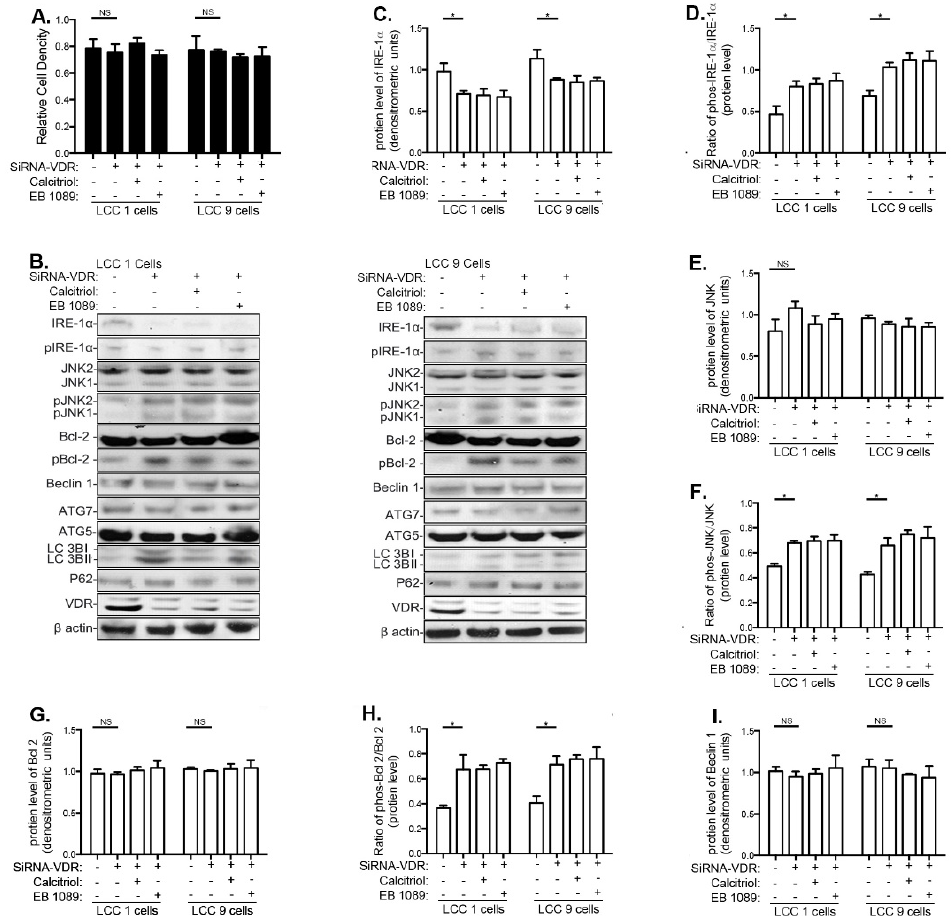
Figure 5. Silencing VDR prevents the activation of the IRE1 α -JNK signaling pathway in calcitriol- and EB1089-treated breast cancer cells. ( A ) siRNA- and siRNA-VDR-transfected LCC1 and LCC9 cells were treated with vehicle (ethanol), calcitriol (100 nM) or EB1089 (100 nM) for 3 days post-transfection. Relative cell density was determined by crystal violet assay. ( B ) Representative blot from Western blot analysis of siRNA-VDR-transfected LCC1 and LCC9 cells treated with either calcitriol or EB1089. Quantification of protein expression level of ( C ) total IRE1 α , ( D ) the ratio of pIRE-1 α over total IRE-1 α , ( E ) total JNK, ( F ) the ratio of pJNK over total JNK, ( G ) total Bcl-2, ( H ) the ratio of Bcl-2 over total Bcl-2, and ( I ) Beclin 1. Quantification was based upon three independent biologic replications using β -actin as loading control. * p < 0.05. NS: not significant. Means ± standard error of means are shown. In TAM-treated LCC1 cells, inhibiting VDR expression with siRNA prevented the TAM-induced inhibition of cell proliferation (Figure 6A). In LCC9 cells, calcitriol and EB1089 induced sensitization to TAM (Figure 6B). The changes in IRE1 α , JNK, and Bcl-2 seen in cells not treated with TAM, where also seen when cells were treated with TAM. IRE1 α (Supplementary Figure S5B) and upregulated pIRE1 α , pJNK, LC3I